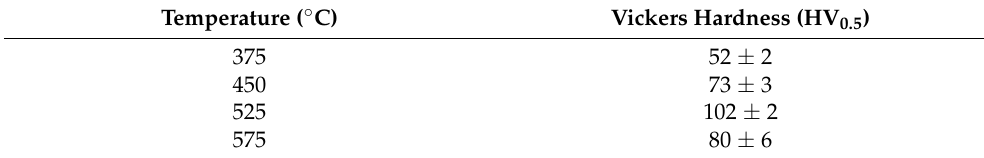
Table 3. Vickers hardness (HV 0.5 ) of bars from green compacts obtained at different extrusion